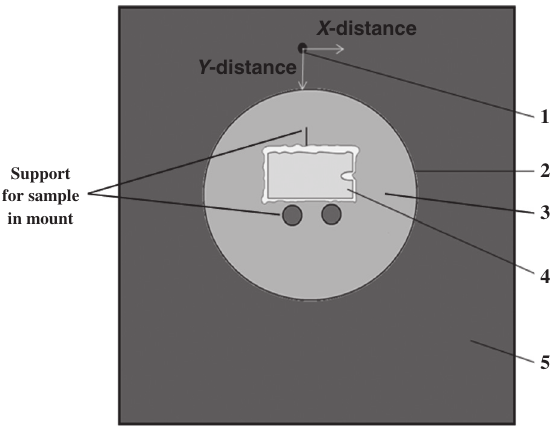
Figure 3: Schematic of a rectangular samples cross section on the digital image